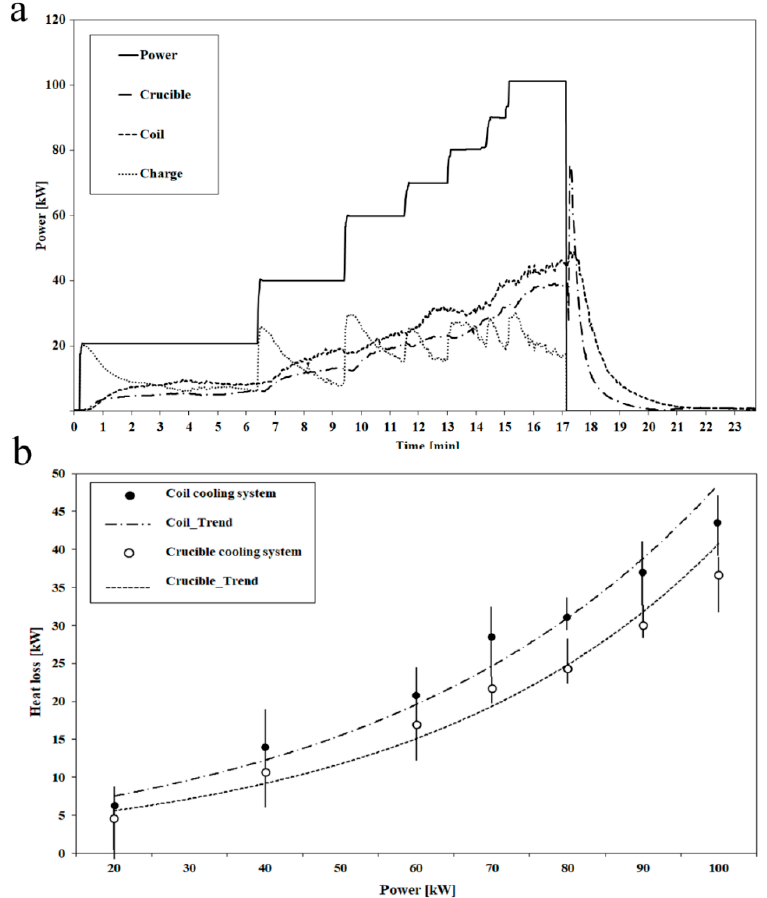
Figure 4. First melting trial: ( a ) Real-time power balance. ( b ) Heat losses in each ISM sub-assembly for each power step.